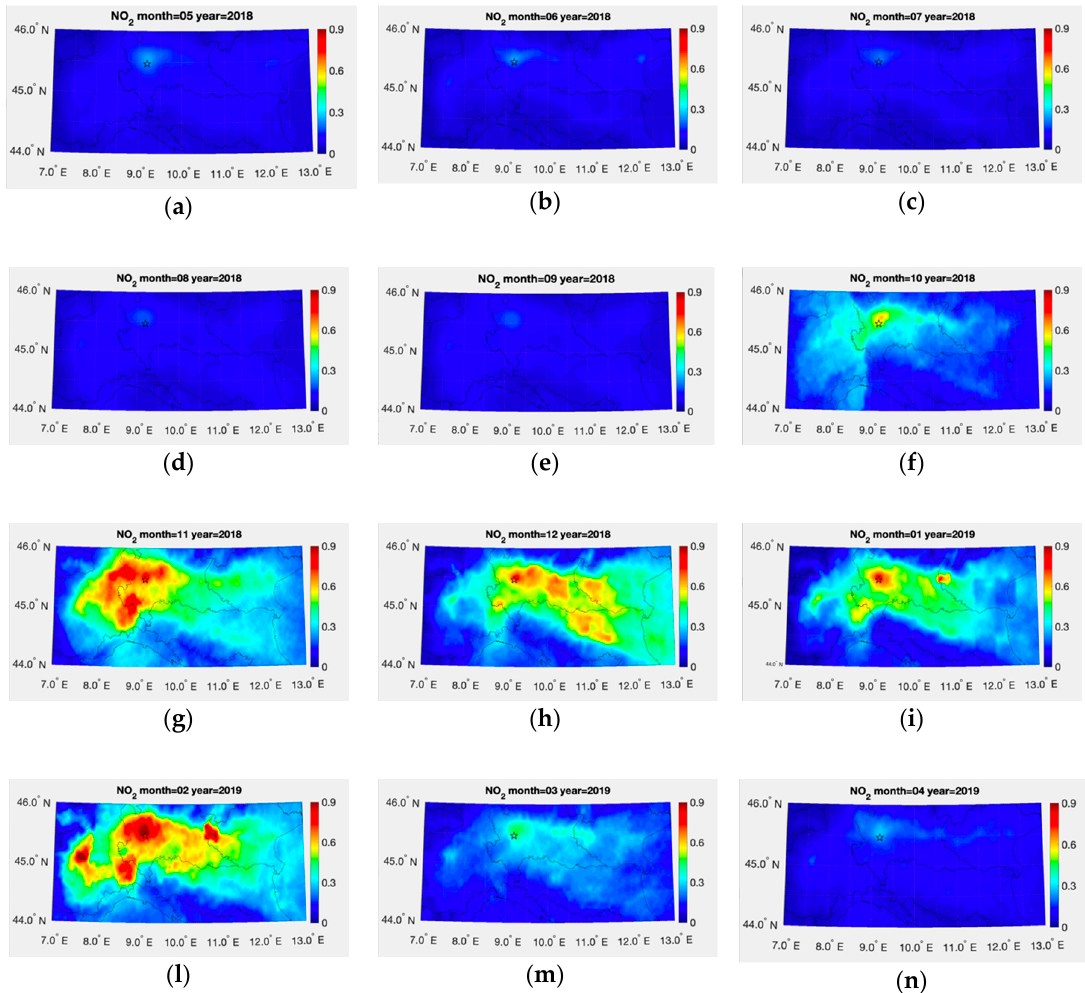
Figure 13. Monthly maps of Level 3 NO 2 tropospheric column (Dobson) over the Po Valley area during the period between May 2018 and April 2019. In particular, May ( a ), June ( b ), July ( c ), August ( d ), September ( e ), October ( f ), November ( g ), December ( h ) 2018 and January ( i ), February ( l ), March ( m ), April ( n ) 2019. The star indicates the city of Milan.